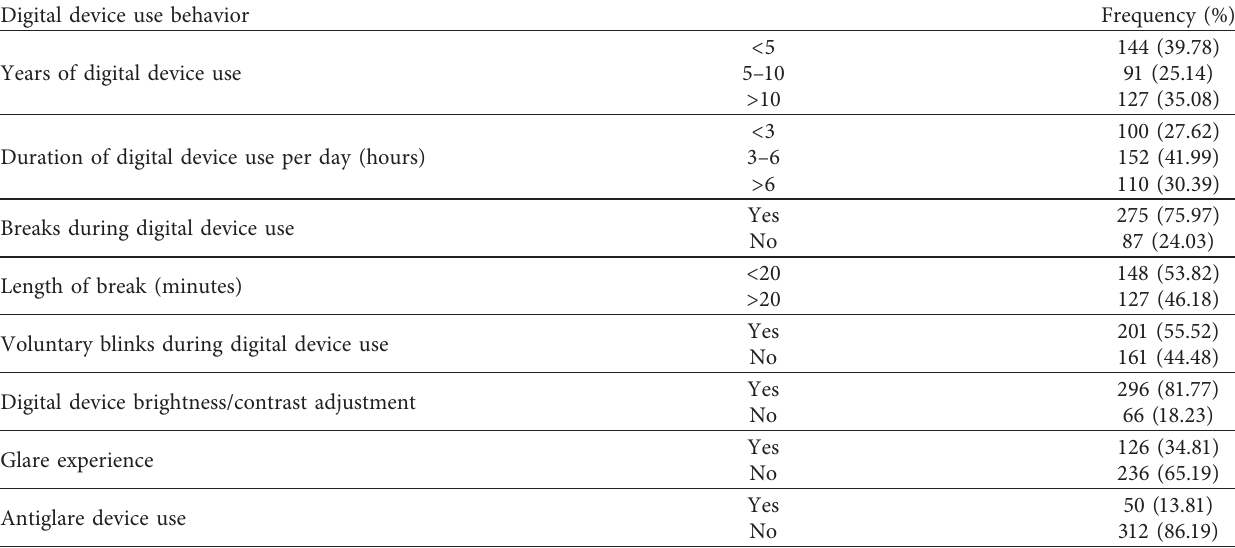
Table 2: Digital device use behavior of study